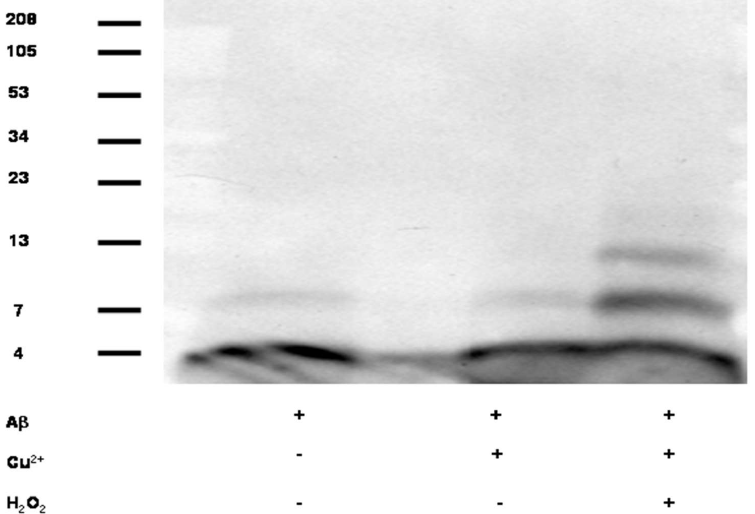
Figure 1. Cu and H 2 O 2 exacerbated A β oligomerization in vitro . Western blot represented purified A β 1-40 (11.3 µ M) alone (lane 1) or treated with 50 µ M Cu 2 + (lane 2) or 50 µ M Cu 2 + + 250 µ M H 2 O 2 (lane 3). Bands were detected using an anti-A β monoclonal antibody (6E10) that recognizes the N-terminus of A β (see Methods for Western blot